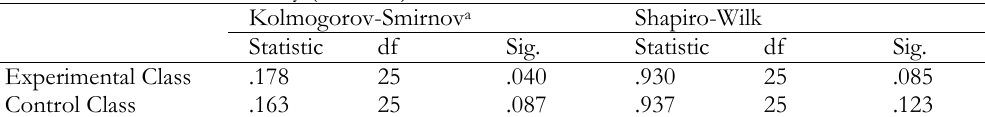
TABLE 2. Tests of Normality (Post-test)